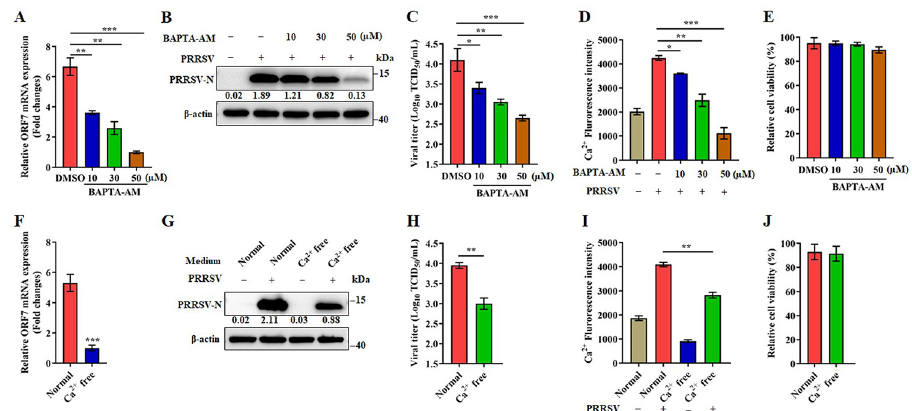
Fig 2. Intracellular Ca 2+ benefits PRRSV replication. (A-E) BAPTA inhibits PRRSV infection. Marc-145 cells were mock or PRRSV infected (MOI = 0.1) for 24 h with different doses of BAPTA-AM. ( A ) RT-PCR for detection of PRRSV ORF7 (N protein). ( B ) Western blot of PRSSV N protein. ( C ) Viral titers as a function of BAPTA concentration. ( D ) Cytoplasmic Ca 2+ induction after PRRSV infection, with and without BAPTA-AM. ( E ) Cell viability of Marc-145 cells treated with BAPTA-AM at indicated concentrations or DMSO for 24 h. (F-J) Exogenously supplied Ca 2+ promotes PRRSV replication. Marc-145 cells were infected with PRRSV (MOI = 0.1) and then